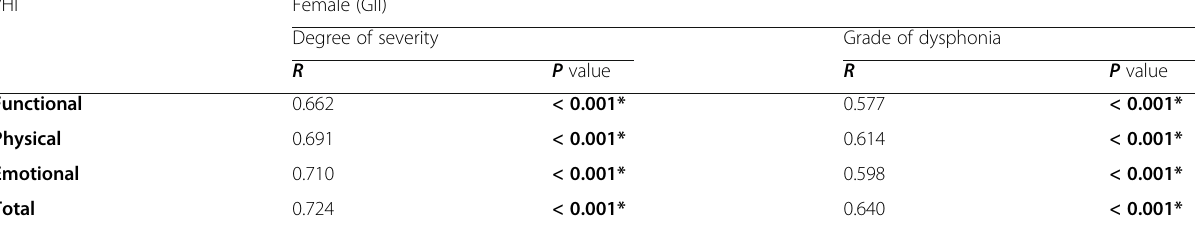
Table 10 Correlation between VHI and grade of dysphonia in female teachers VHI